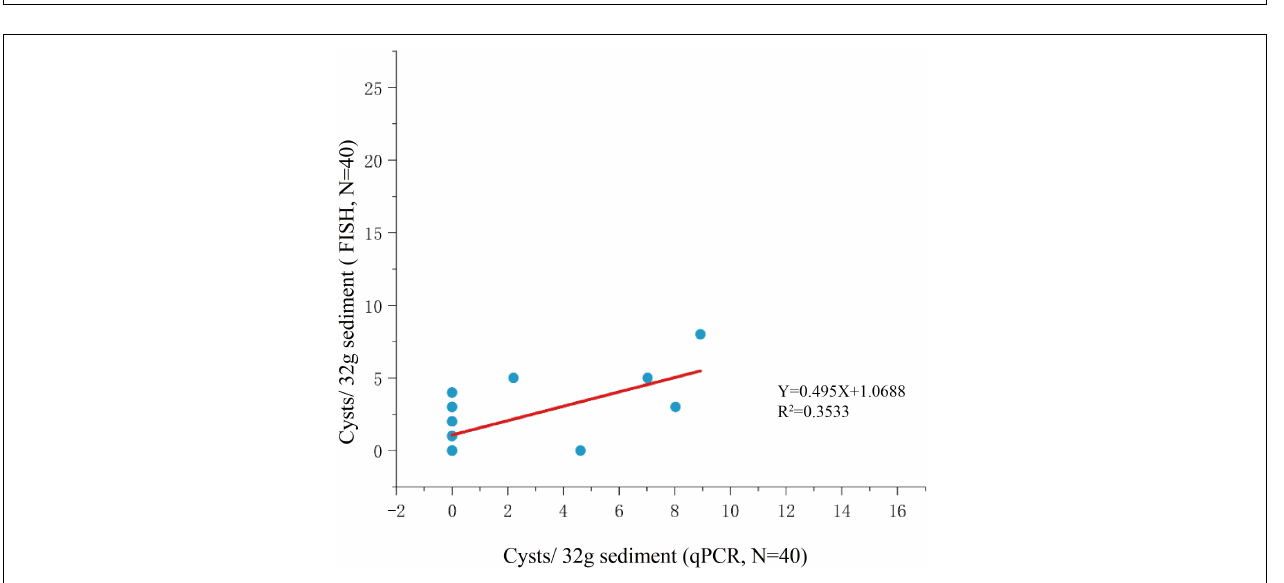
FIGURE 8 | Distribution and abundance of Prorocentrum donghaiense cysts in the sediments along the China coasts as quantified using real-time PCR in combination with FISH method.